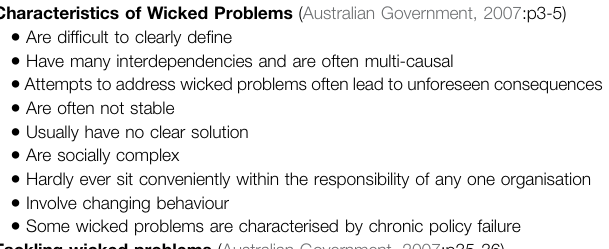
TABLE 2 | Characteristics of and tackling wicked problems (Australian Government, 2007). Characteristics of Wicked Problems (Australian Government, 2007:p3-5) (cid:129) Are dif fi cult to clearly de fi ne (cid:129) Have many interdependencies and are often multi-causal (cid:129) Attempts to address wicked problems often lead to unforeseen consequences (cid:129) Are often not stable (cid:129) Usually have no clear solution (cid:129) Are socially complex (cid:129) Hardly ever sit conveniently within the responsibility of any one organisation (cid:129) Involve changing behaviour (cid:129) Some wicked problems are characterised by chronic policy failure Tackling wicked problems (Australian Government, 2007:p35-36) An evolving art, but one which seems to at least require: (cid:129) Holistic, not partial or linear thinking (cid:129) Innovative and fl exible approaches (cid:129) The ability to work across agency boundaries (cid:129) Increasing understanding and stimulating a debate on the application of the accountability framework (cid:129) Effectively engaging stakeholders and citizens in understanding the problem and in identifying possible solutions (cid:129) Additional core